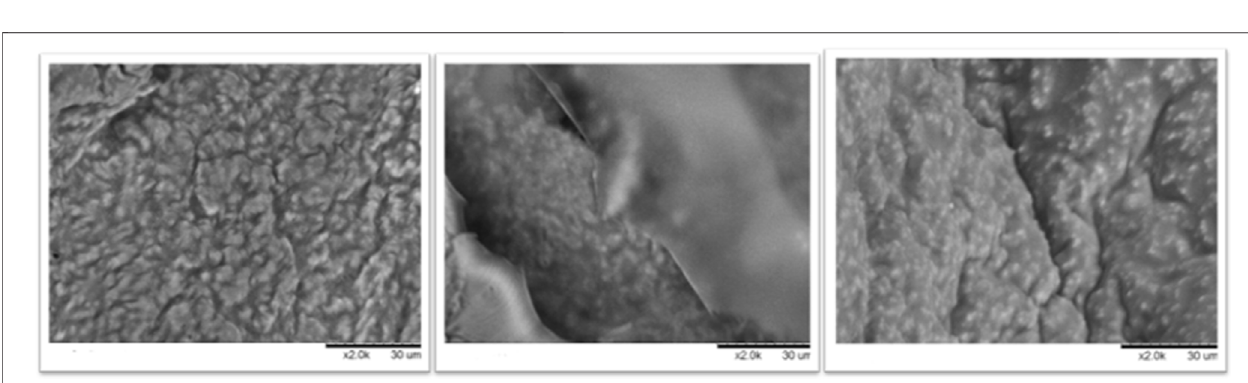
Frontiers in Bioengineering and Biotechnology |